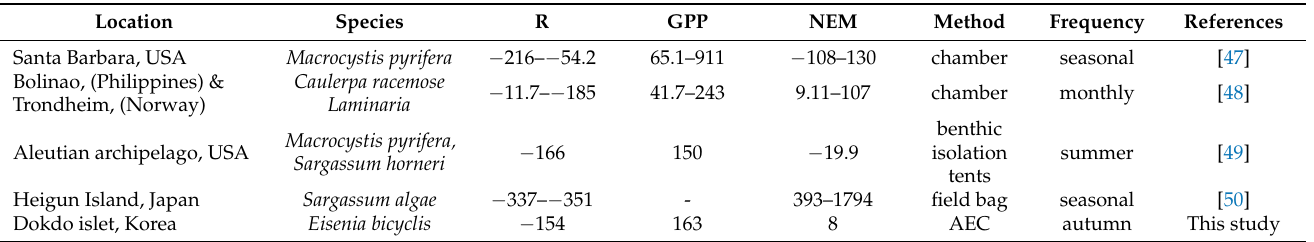
Table 2. Comparison of net ecosystem metabolism in various regions of the macroalgal communities. All units of respiration (R), gross primary production (GPP), and net ecosystem metabolism (NEM) are in mmol O 2 m − 2 d − 1